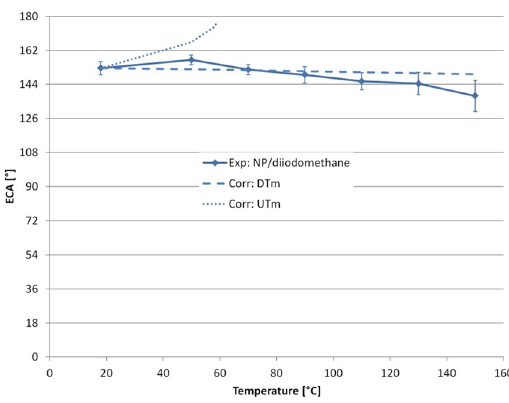
Figure 5. Evaluation of the ECA at different temperatures for a diiodomethane droplet on NP surface. The temperature range is 20 °C < T w < 150 °C. The experimental values are compared respectively with the decreasing trend model (DTm, dashed line) and the unsymmetrical trend model (UTm, dotted line). The parameters of the model are set in order to have the same ECA at 20